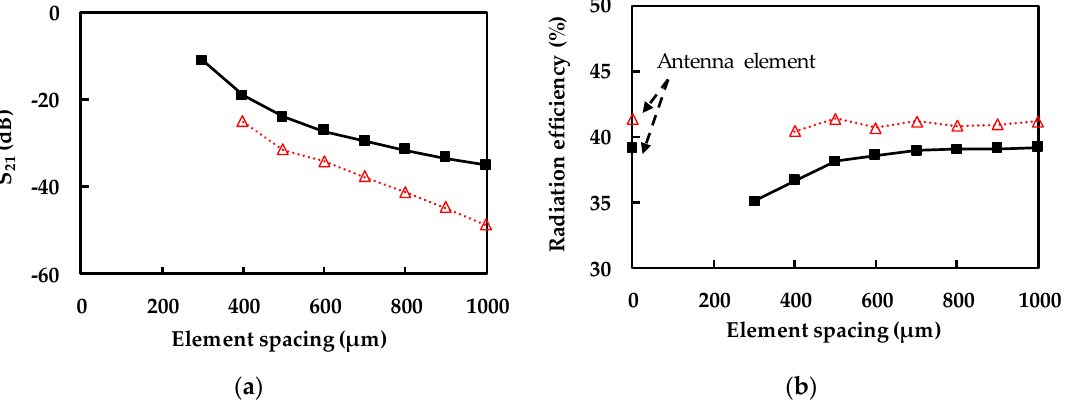
Figure 4. Simulated results of ( a ) coupling and ( b ) radiation efficiency at 300 GHz (squared: without DGS, triangle: with DGS).